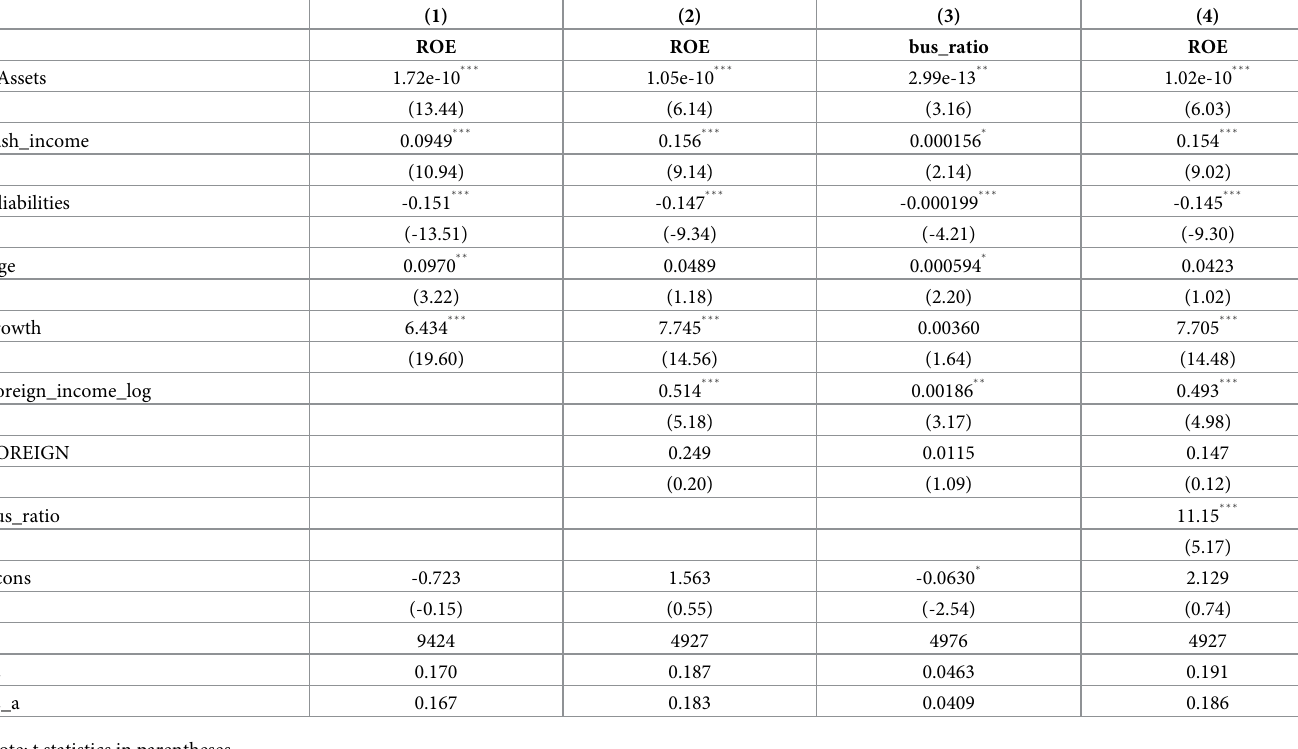
Table 2. The mediating effect of business